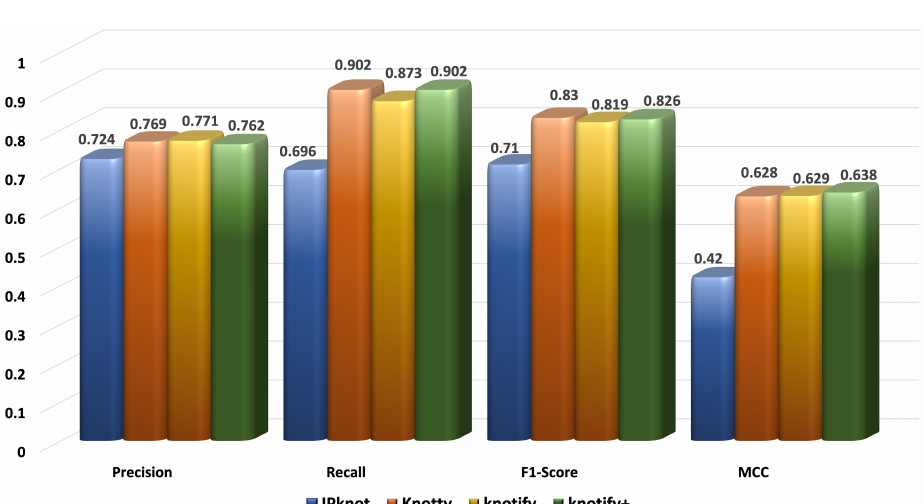
Figure 7. Metrics for the sequences of length ≥ 30 and < 40.